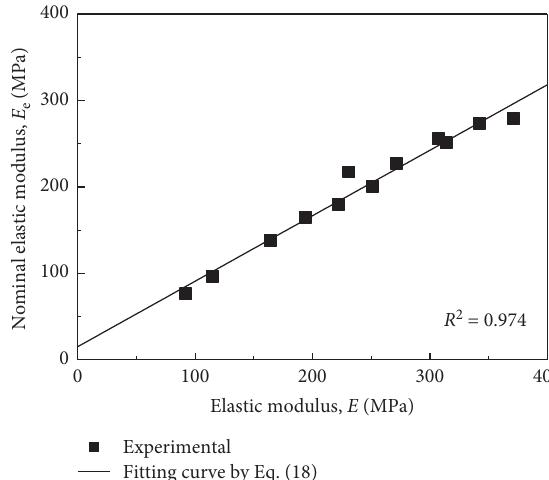
Figure 13: Relationship between E and E